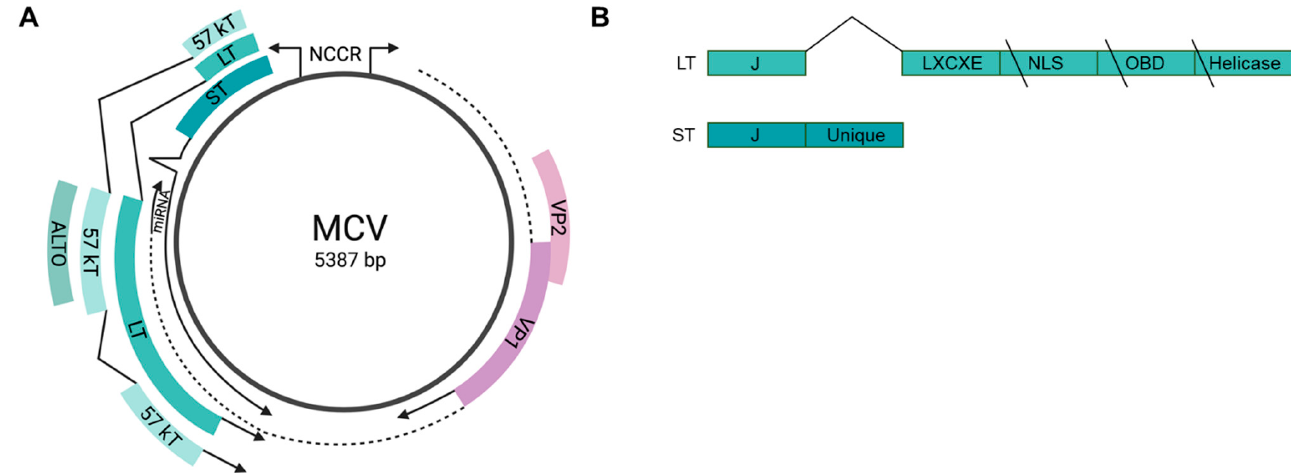
Figure 1. MCV genome . ( A ) Circular map of the MCV genome depicting early (green) and late (purple) genes and the non ‐ coding control region (NCCR). Created with BioRender.com (accessed on 1 November 2021) ( B ) The early gene region undergoes alternative splicing to produce LT and ST. The C ‐ terminus of LT is truncated by mutations in MCC, eliminating the nuclear localization signal (NLS), origin binding domain (OBD), and helicase domains while preserving the LXCXE RB ‐ bind ‐ ing motif.